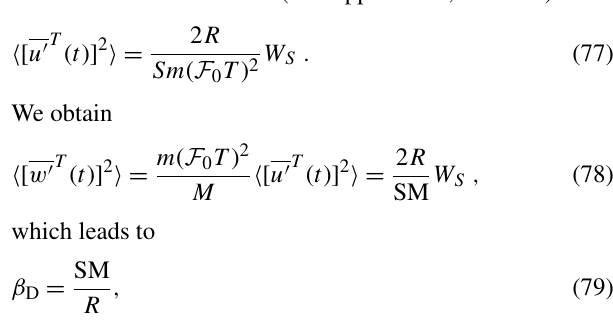
Figure 3. Evolution of the free energy (black) and the work per- formed on the integrated mode (red) from the numerical integration is shown. The evolution is deterministic and periodic and results agree with the analytic